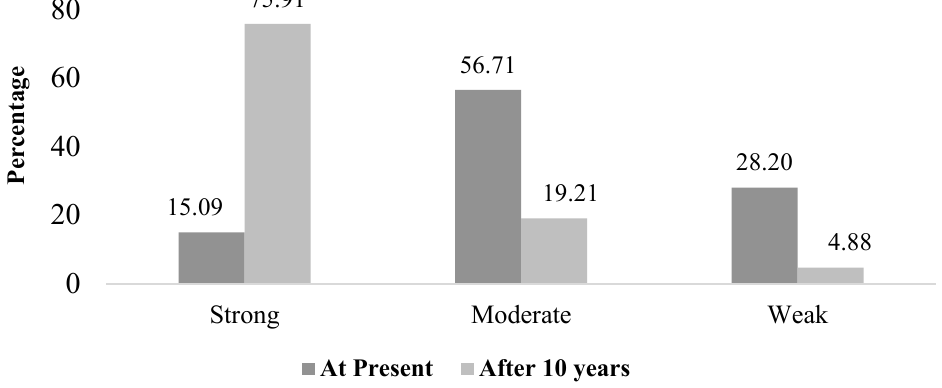
At Present Figure 4. Percent of survey respondents classified by perceptions of risk that birds and their habitats may be worse off today and in 10 years ( n = 656).